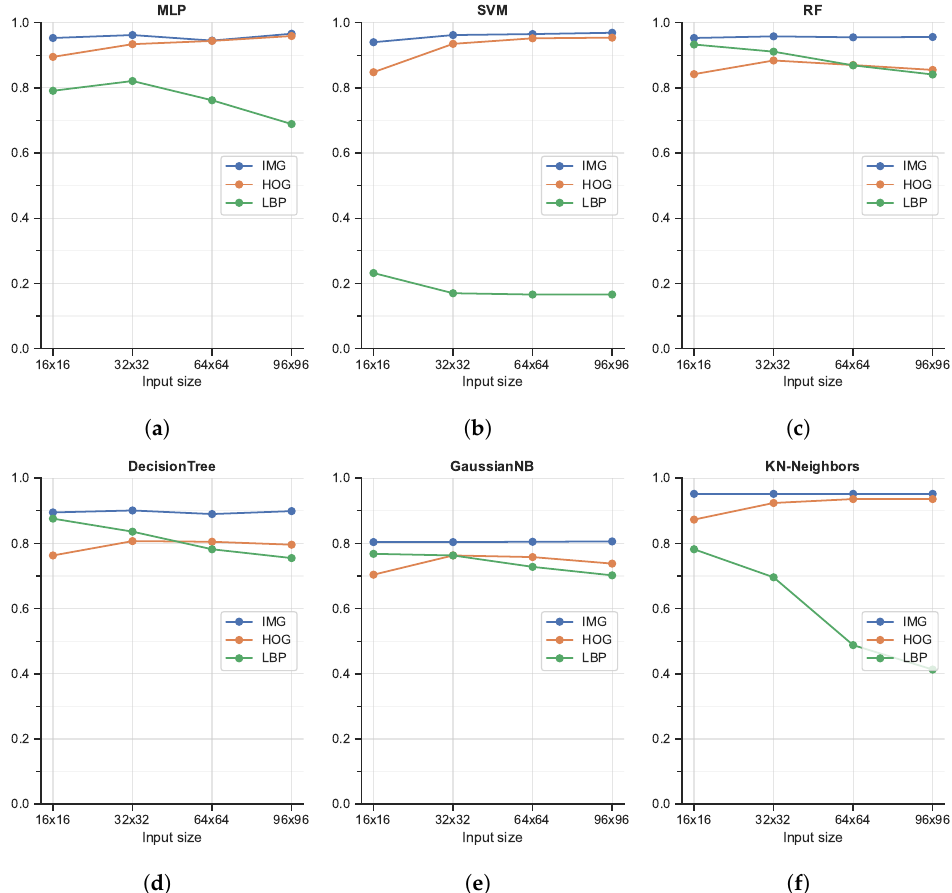
Figure 6. Classification accuracy of the three Machine Learning-based classifiers across different input sizes and input features: ( a ) shows the performance of the Multi-Layer Perceptron (MLP) classifier, while ( b ) shows the Support Vector Machine (SVM) classifier, ( c ) Random Forest (RF), ( d ) Decision Tree classifier, ( e ) Gaussian Naive Bayes (GaussianNB) classifier, and ( f ) K-nearest neighbors (KN-neighbors)